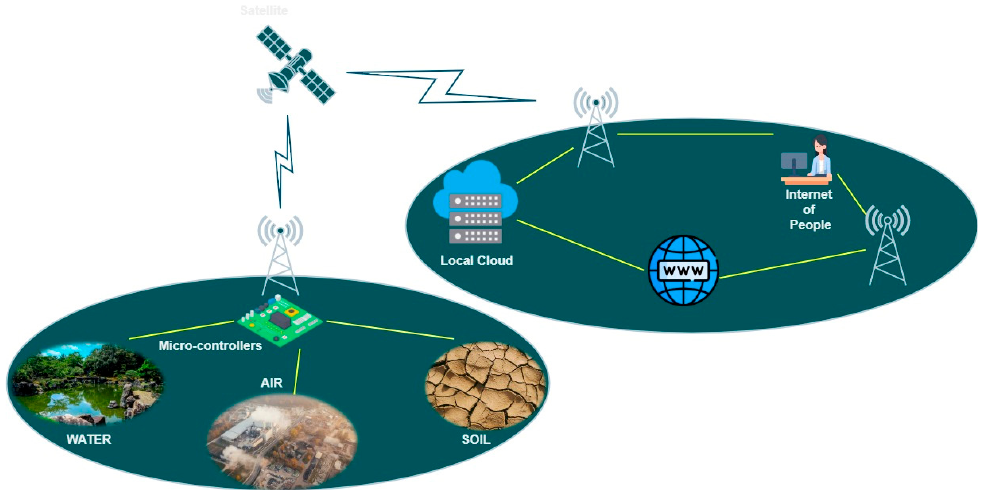
Figure 2. Sample IoT systems for environmental monitoring applications.